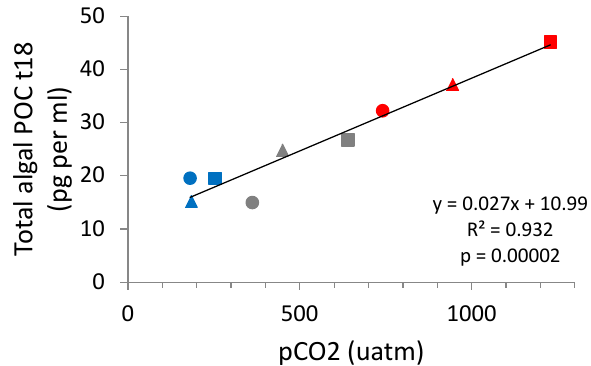
Fig. 4. Total algal POC versus p CO 2 . The CO 2 concentrations plot- ted were the averages of t 8 to t 18. For color and symbol coding, see Fig. 1. Linear regression statistics provided in plots.